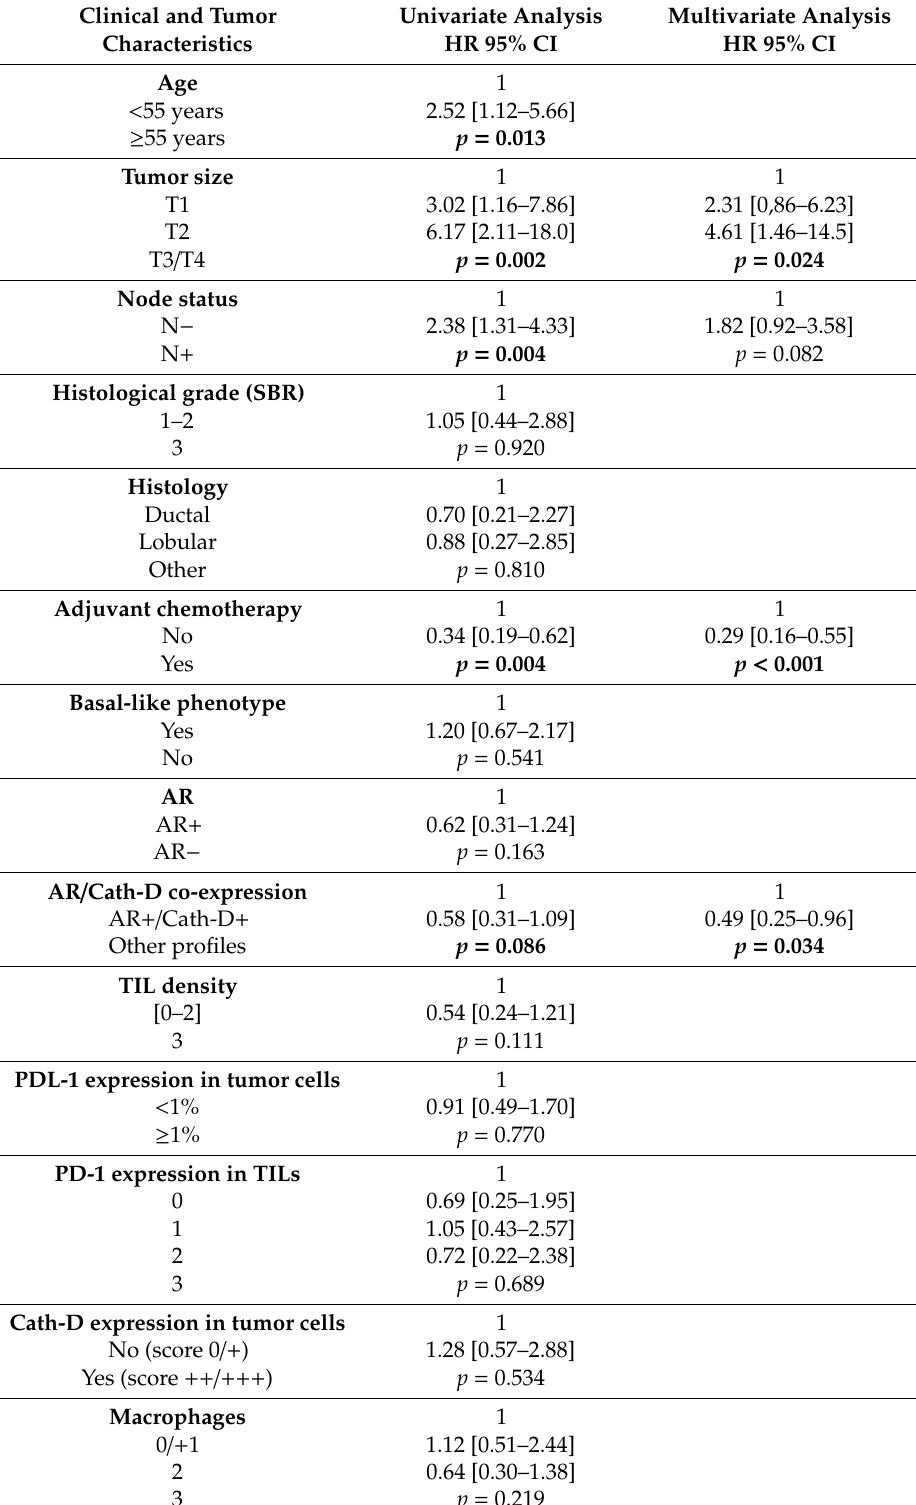
Table 4. Univariate and multivariate analyses for overall survival